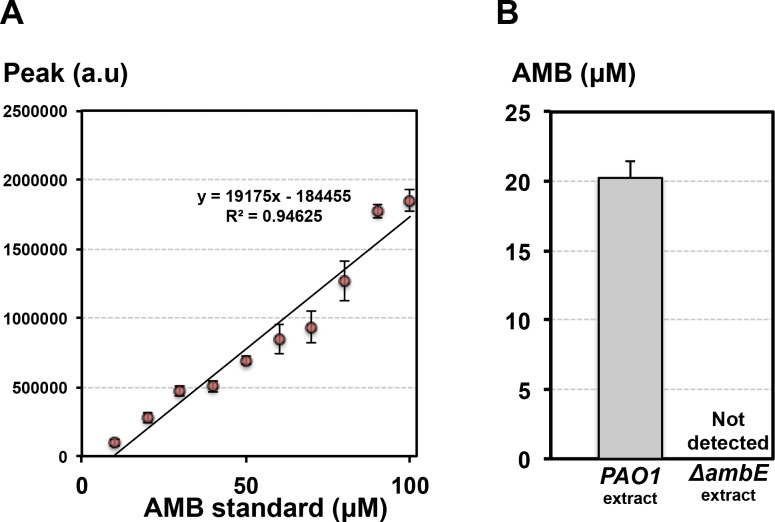
Quantification of AMB in Pseudomonas extracts.(A) Calibration curve using synthetic AMB used for quantification. Data represent mean ± standard deviation (three replicates). (B) Quantification of AMB in Pseudomonas extracts at 1 mg/mL. Data represent mean ±standard deviation (three replicates). Bioactivity of the same extracts were represented in Figure 4E.